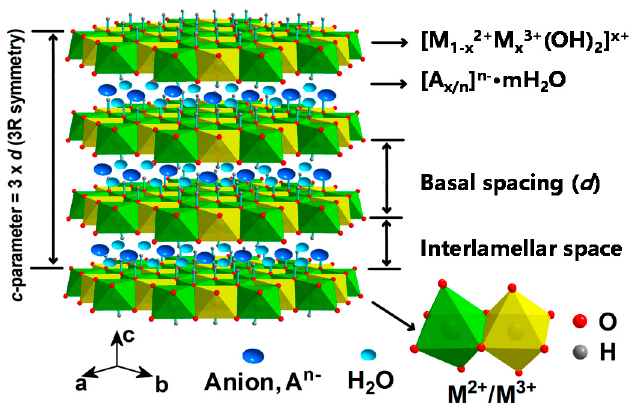
Figure 2. Schematic representation of the typical LDHs structure [100]. Copyright 2017, MDPI.